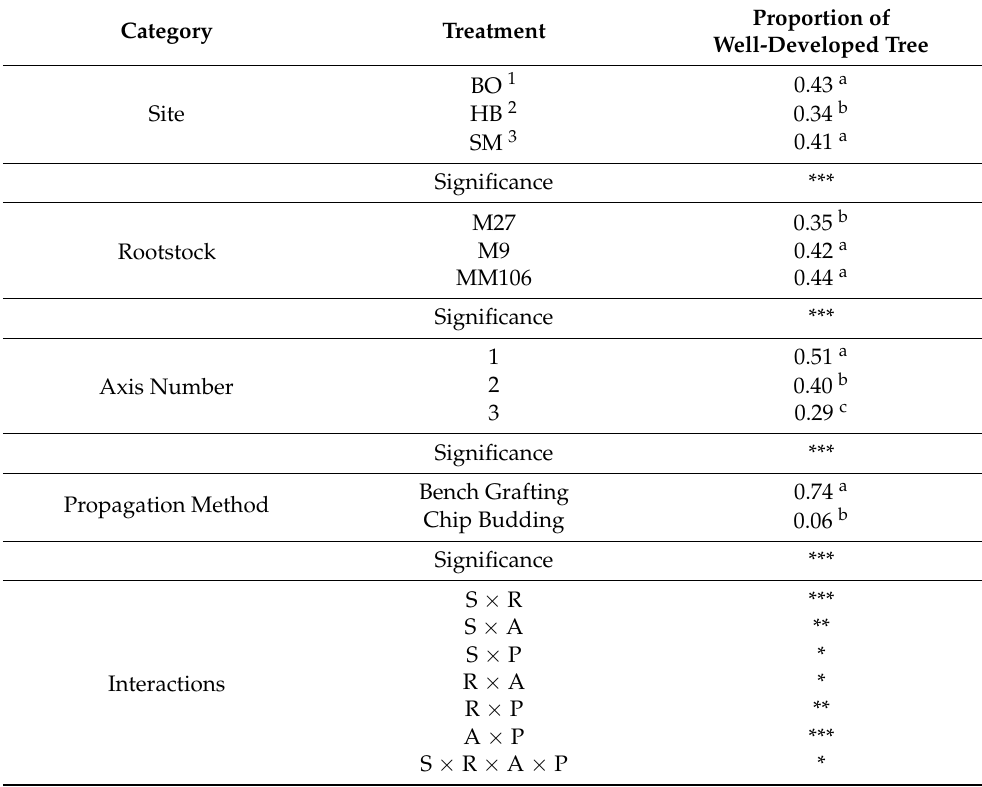
Table 1. Main effect of the treatments on the proportion of well-developed trees grown over their first season of growth at three different